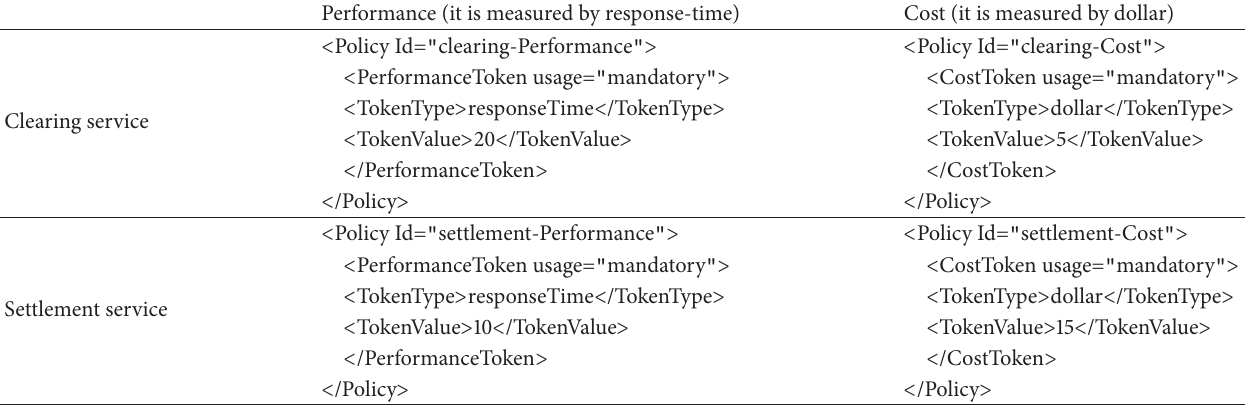
Table 1: Performance and cost policies.